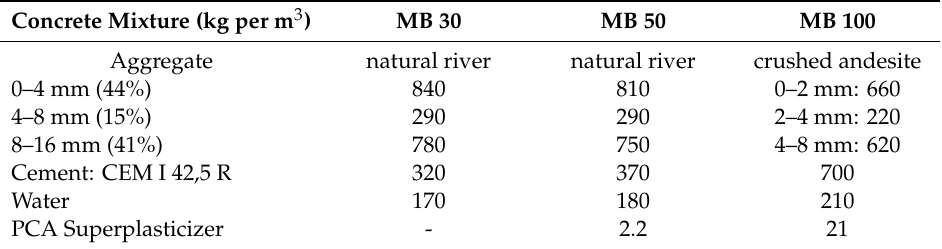
so thirteen samples were tested. Six samples of MB 100 were casted: two for compressive strength, ◦ ◦ and four for shear test (70 and 80